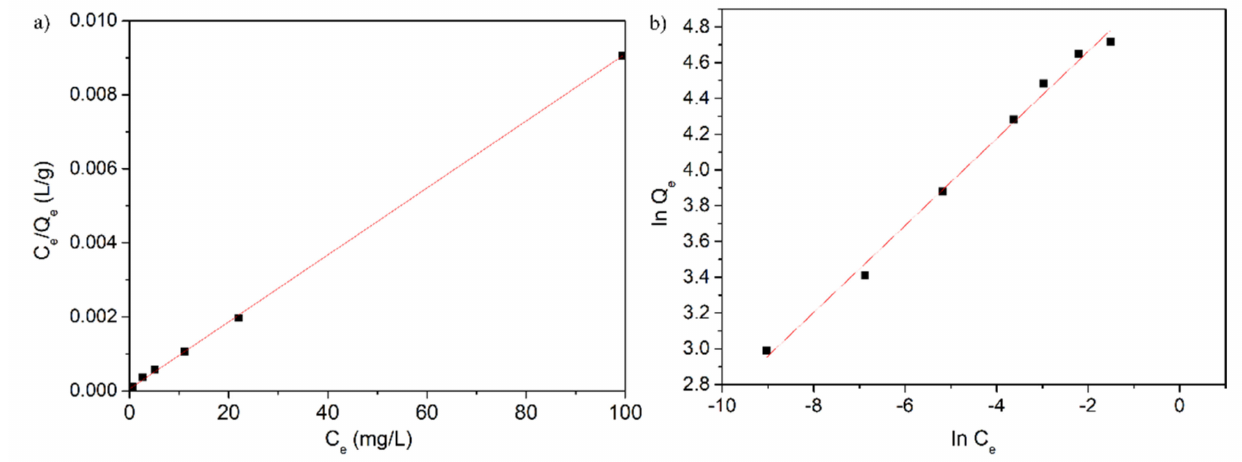
Figure 8. Langmuir ( a ) and Freundlich ( b ) graphical linearized equations for the adsorption of lead ions on HAp- CTAB